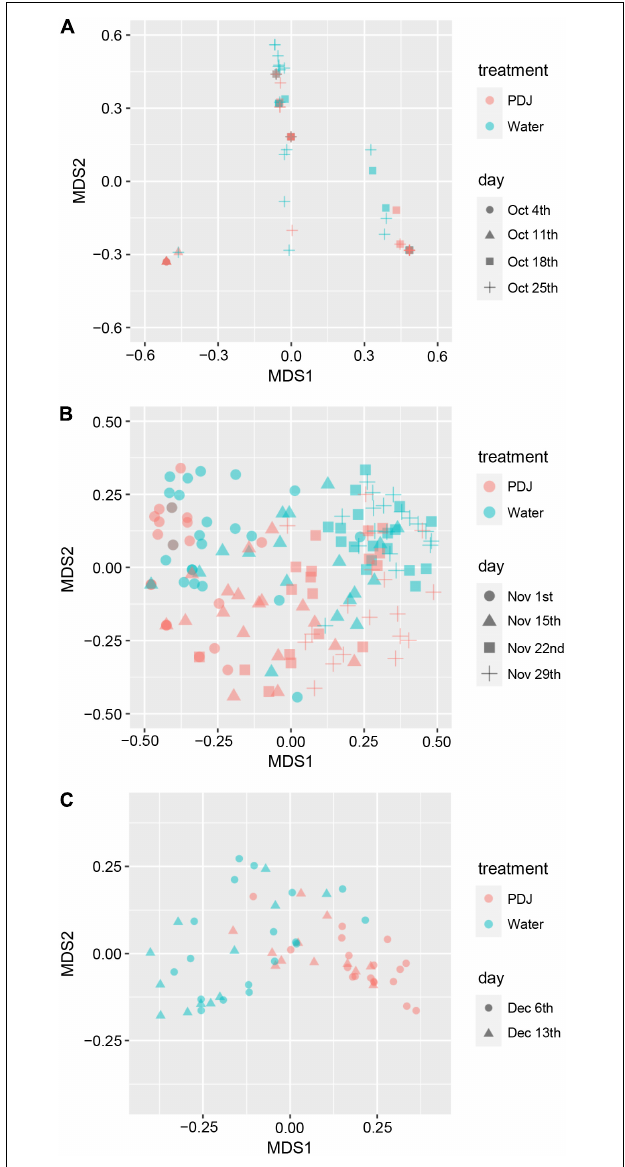
FIGURE 3 | Multidimensional scaling plot (for the first two axes) using a principal coordinates analysis (PCoA) of a Bray–Curtis distance matrix on the data of insect community composition on plants treated with water and those treated with prohydrojasmon (PDJ) in October (A) , November (B) , and December (C) .